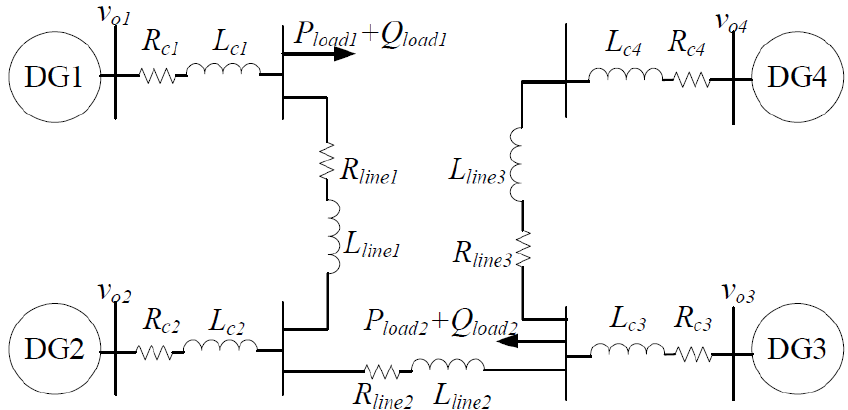
Figure 6. Test islanded MG.